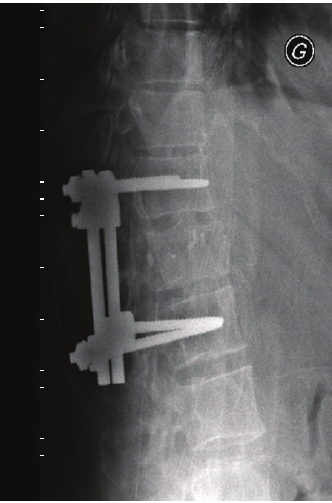
Figure 3: Postoperative lateral X-ray showing the height restitution of T12.